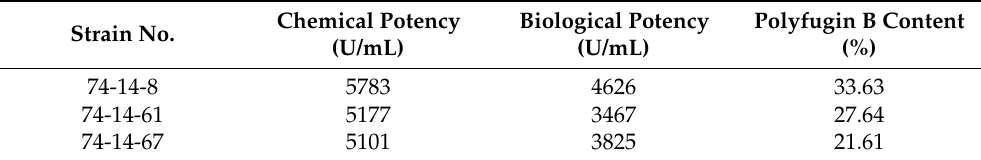
Table 3. Biological potency and Polyfungin B contents of various strains after the first round of UV mutagenesis.